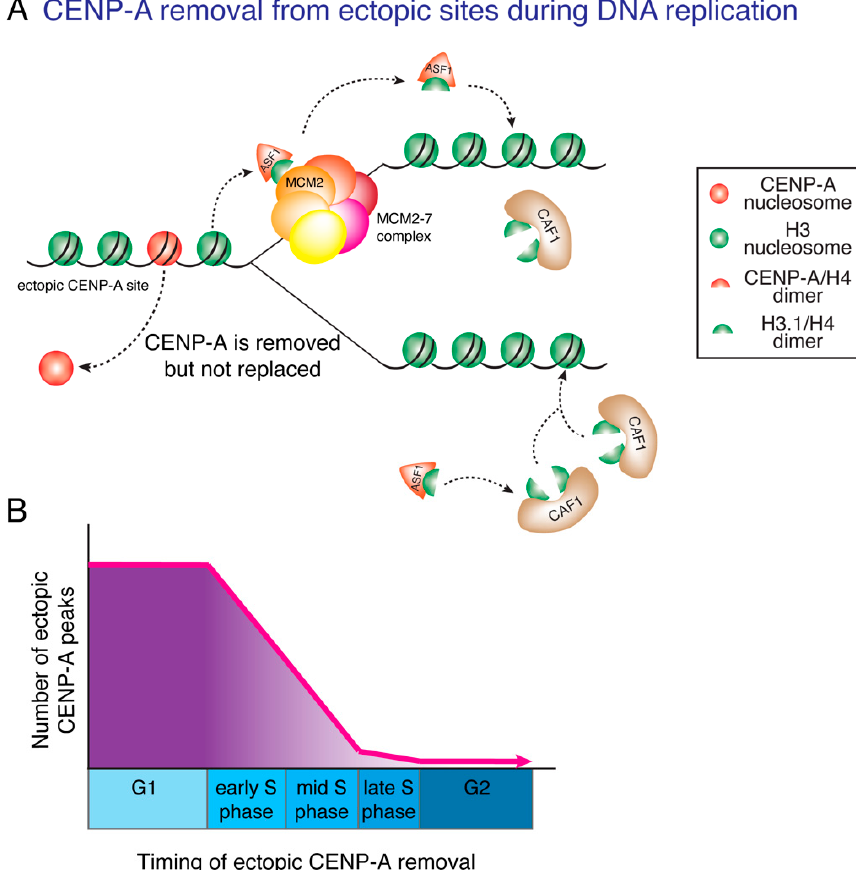
Figure 3. Ectopically loaded CENP-A is removed during DNA replication. ( A ) DNA replication corrects errors in CENP-A deposition by removing ectopic CENP-A from non-centromeric sites. As ectopic CENP-A is not tethered to the replication fork by the CCAN, it is removed from ectopic sites during DNA replication and diluted in the pool of available histones. CENP-A is replaced by histone H3.1:H4 dimers through the combined action of MCM2 and the chaperone ASF1. ( B ) Ectopic CENP-A is primarily found at early- and mid-replicating DNA regions and is removed as replication proceeds during S phase. At the end of S phase, nearly all CENP-A molecules have been removed from ectopic sites.